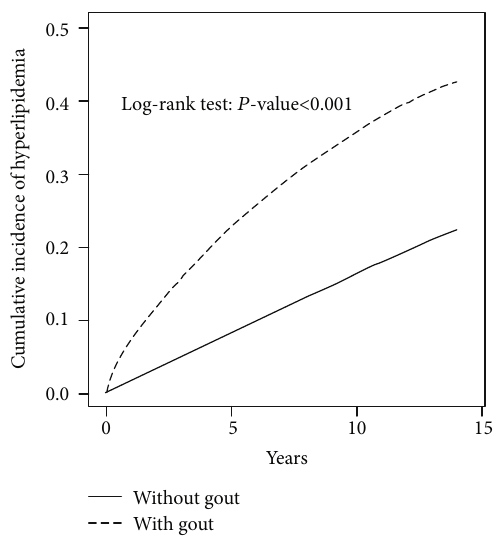
Figure 1: Comparison of cumulative incidence of hyperlipidemia between patients, with and without gout, using the Kaplan-Meier method. Comparison cohort mean follow-up year = 7 : 76 ( SD = 3 : 93 ). Case cohort mean follow-up year = 6 : 60 ( SD = 4 : 11